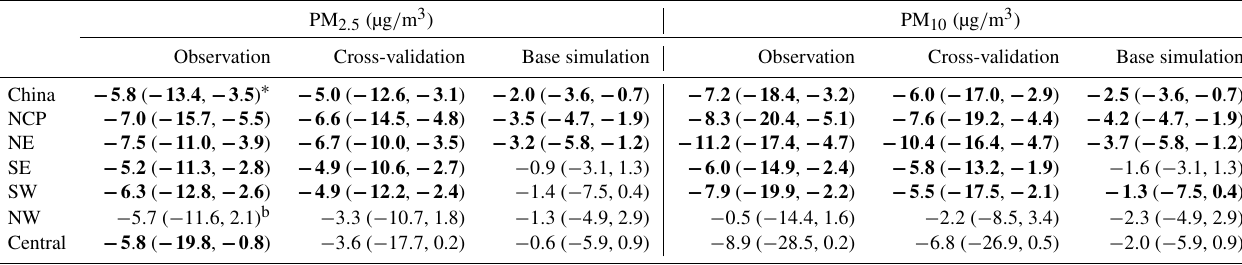
Table 3. Calculated annual trends of the PM 2 . 5 and PM 10 concentrations in China.